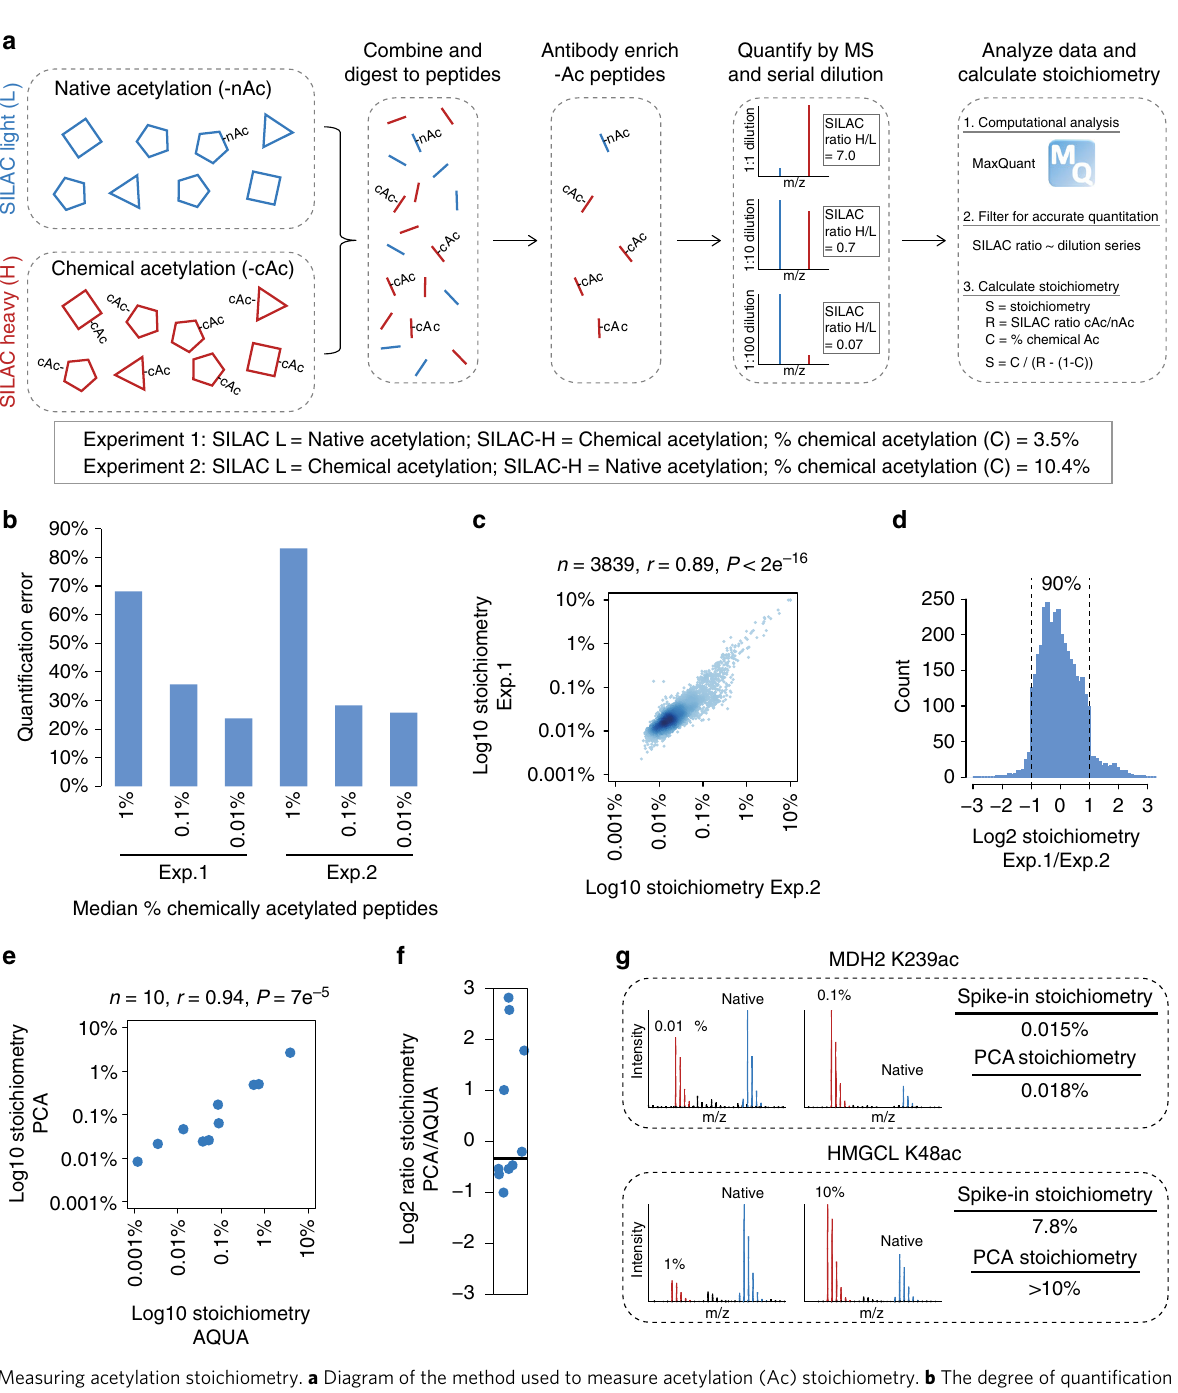
Fig. 1 Measuring acetylation stoichiometry. a Diagram of the method used to measure acetylation (Ac) stoichiometry. b The degree of quanti fi cation error as determined by the fraction of SILAC ratios at each concentration of chemically acetylated peptides that was not consistent with SILAC ratios measured in at least one different concentration of chemically acetylated peptides. c The correlation between stoichiometry measured in independent experimental replicates. The number of peptides ( n ), Pearson ’ s correlation ( r ), and P -value ( P ) of correlation are shown. d Low absolute variability between experimental replicates. The histogram shows the distribution of Log2 ratios of stoichiometry in Experiment 1/Experiment 2 (Exp.1/Exp.2). e The correlation between stoichiometry measured using partial chemical acetylation (PCA) and absolute quanti fi cation (AQUA) peptide standards. f Low absolute variability between stoichiometry measurements made by PCA and AQUA. g Validation of stoichiometry measurements using recombinant acetylated (100%) proteins as a spike-in standard. Stoichiometry was measured at two different concentrations of spike-in protein (SILAC light, red) compared to SILAC heavy-labeled HeLa (blue) for each acetylation site. Source data are provided as a Source Data fi